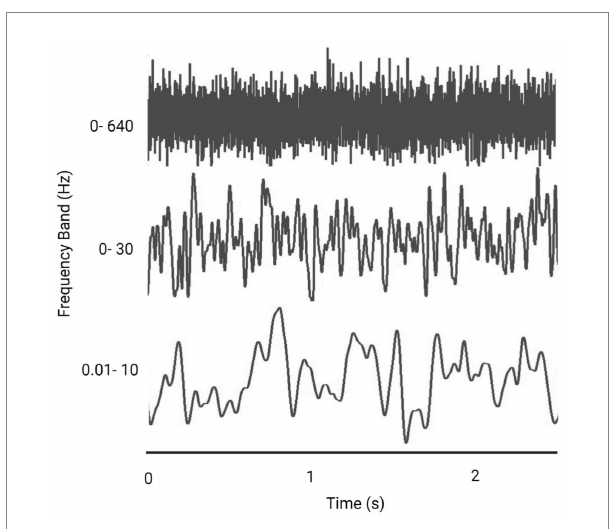
FIGURE 4 Representative figure comparing the effect of frequency bandwidth on a Gaussian white noise signal (Created with